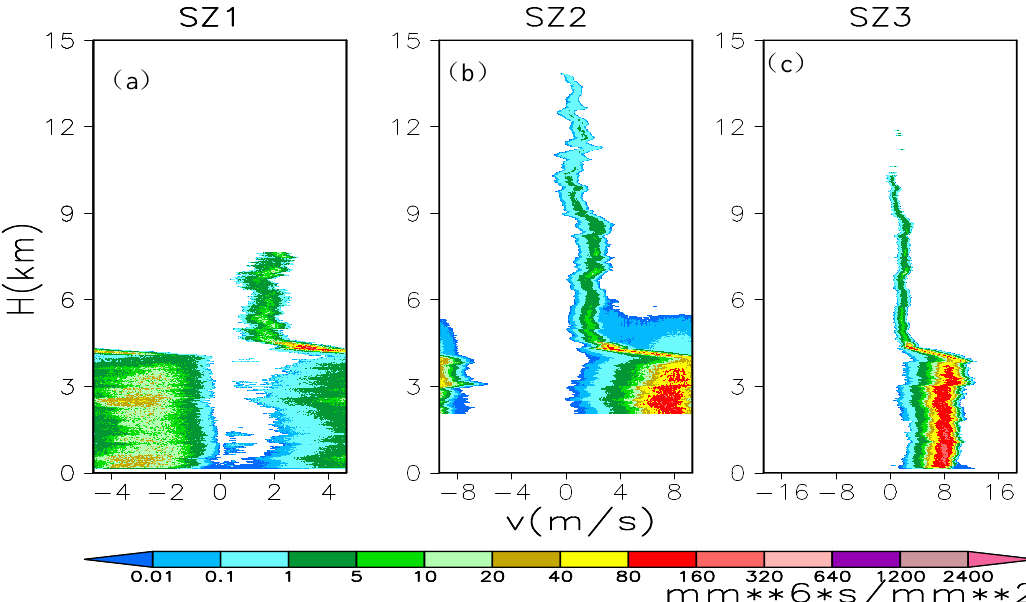
Figure 3. Reflectivity spectra across different heights for the 30th profile observed by ( a ) M1, ( b ) M2, and ( c ) M3. Positive velocities are downward. The left sides of the spectra are aliased in SZ1 and SZ2. Note that there are different maximum velocities for the three work models.